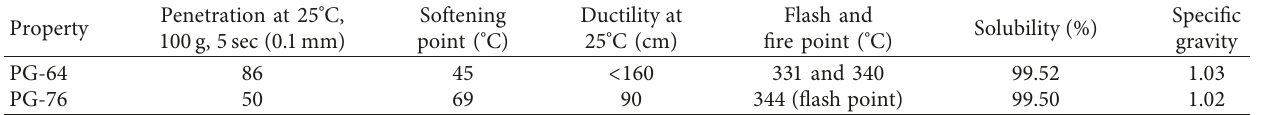
Table 1: Properties of PG-64 and PG-76 binders.